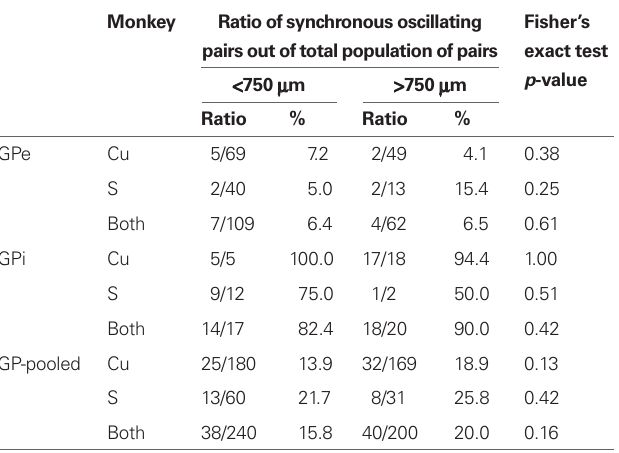
Percentage of synchronous oscillating pairs in an average session in the different nuclei (regardless of the number of pairs recorded in it, similar to Table 3 ). The percentage of significantly synchronous oscillating pairs per session is presented in the second and third columns from the right. As before, the two-tailed t-test hypothesis is that pairs in the two distance categories have the same percentage of